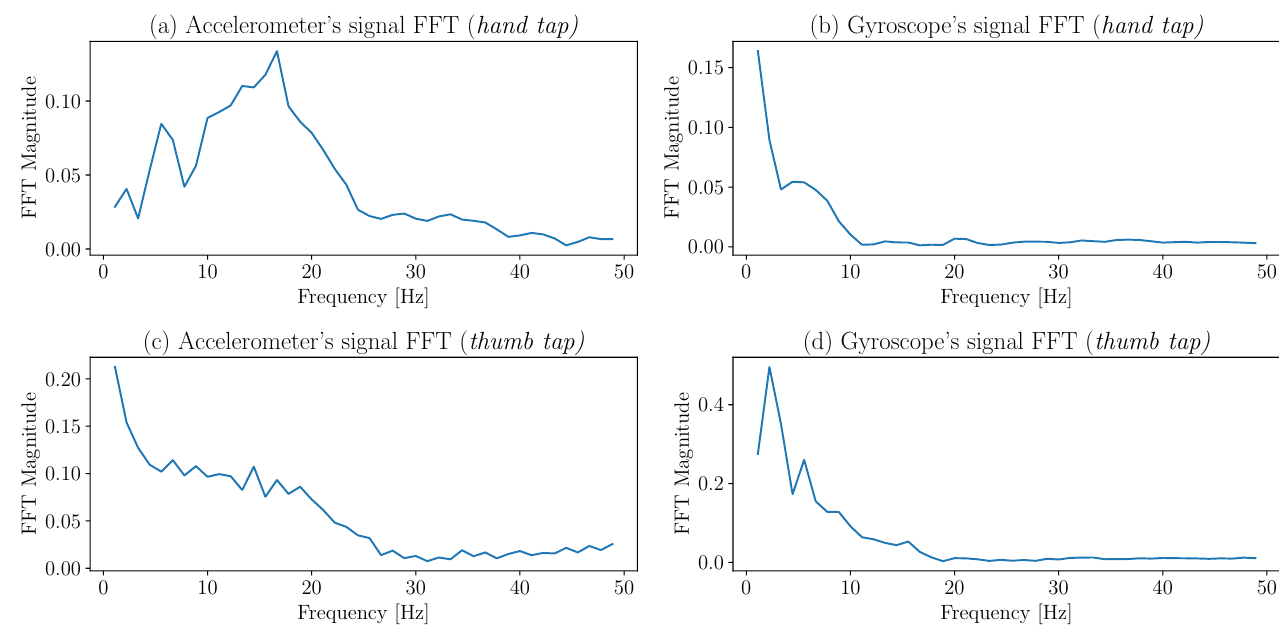
Figure 4. Fast Fourier transform examples for ( a ) a hand tap acceleration, ( b ) a hand tap angular velocity, ( c ) a thumb tap acceleration, and ( d ) a thumb tap angular velocity.